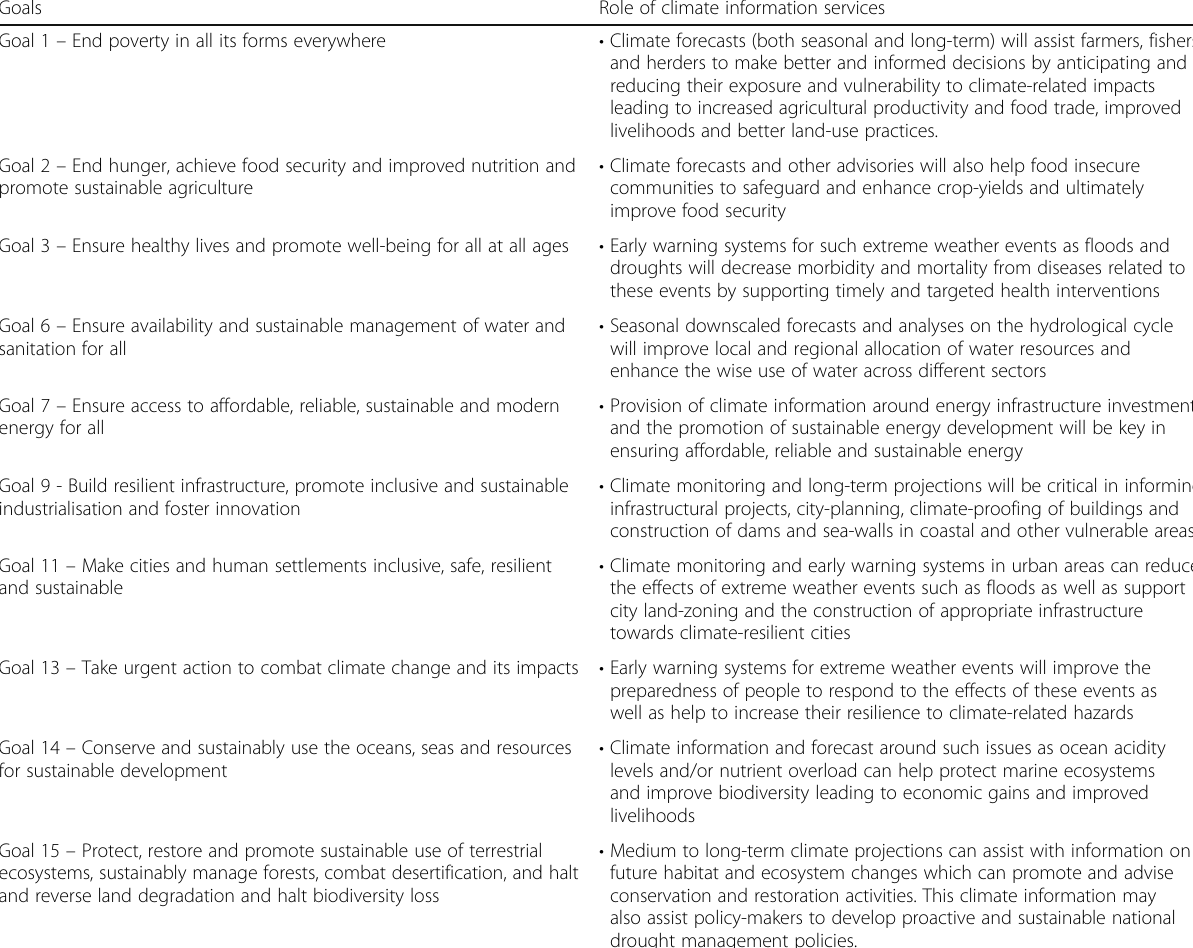
Table 2 Role of climate information services in the achievement of selected SDGs Goals Role of climate information